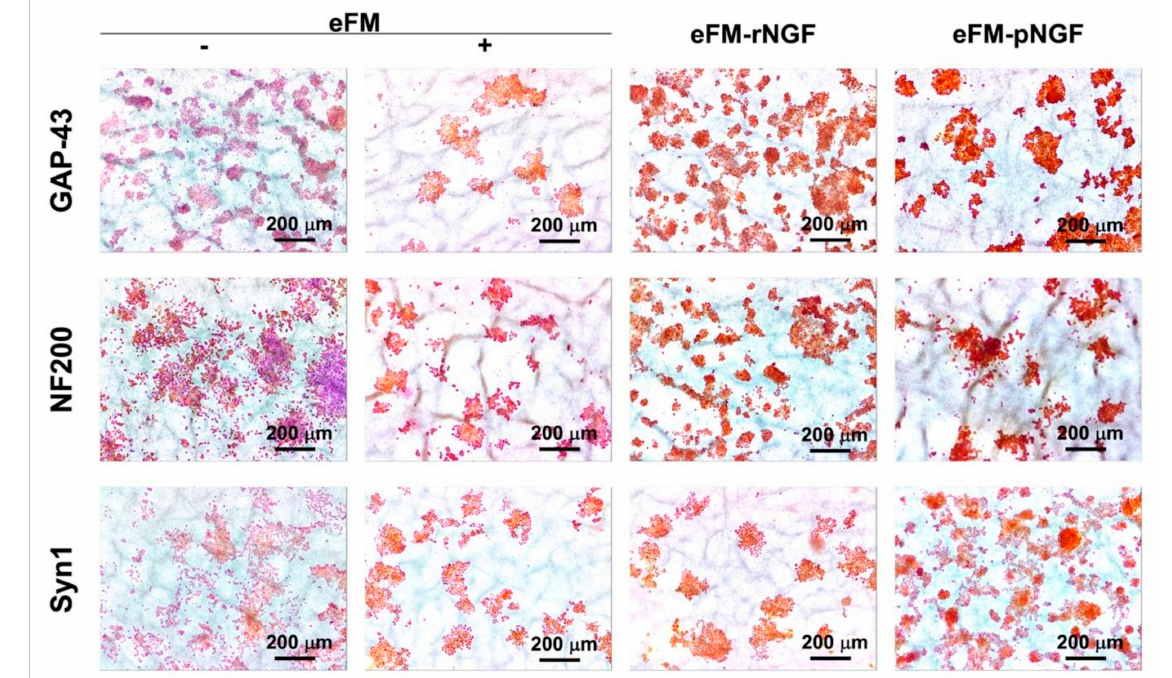
Figure 5. Immunoexpression of GAP-43, NF-200, and Syn1 proteins by the PC12 cells cultured on the different conditions on the 7th